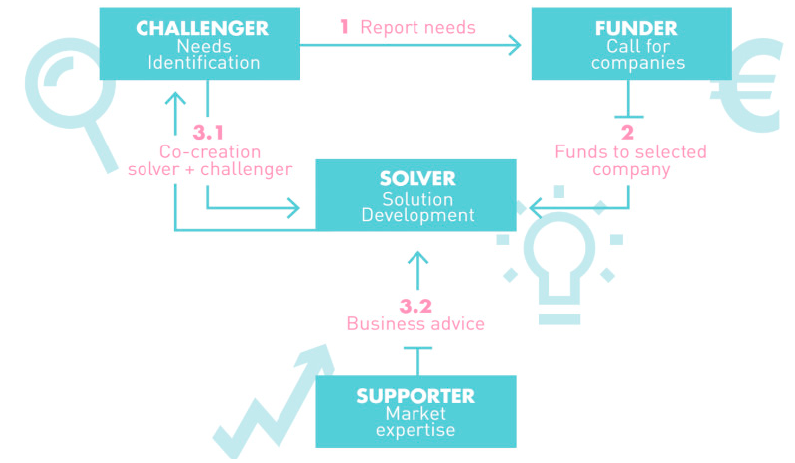
Figure 1. The inDemand model [25].